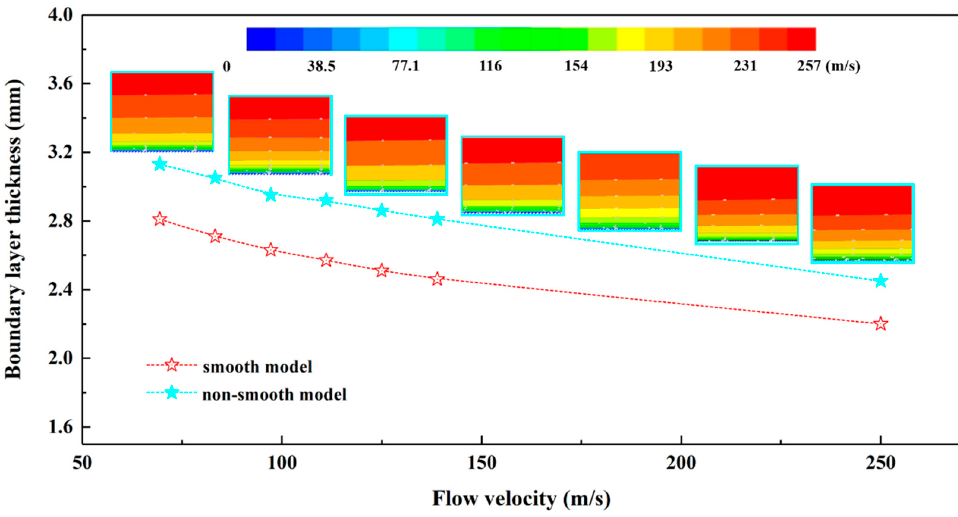
Figure 5. Variation in turbulent boundary layer thickness with flow velocity.